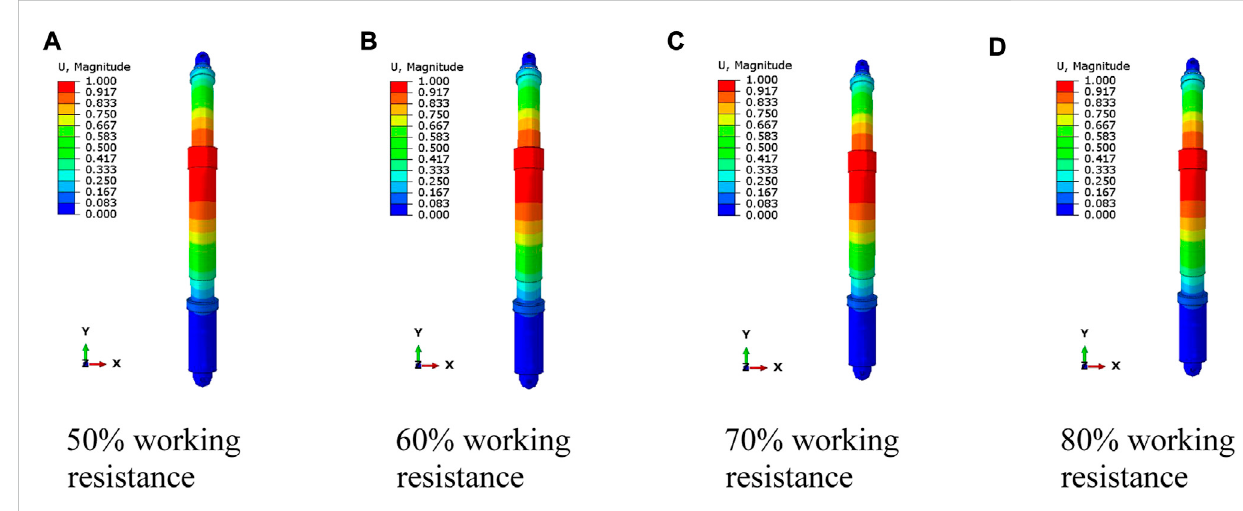
FIGURE 5 1st-order vibration mode of column with different setting forces (A – D) .